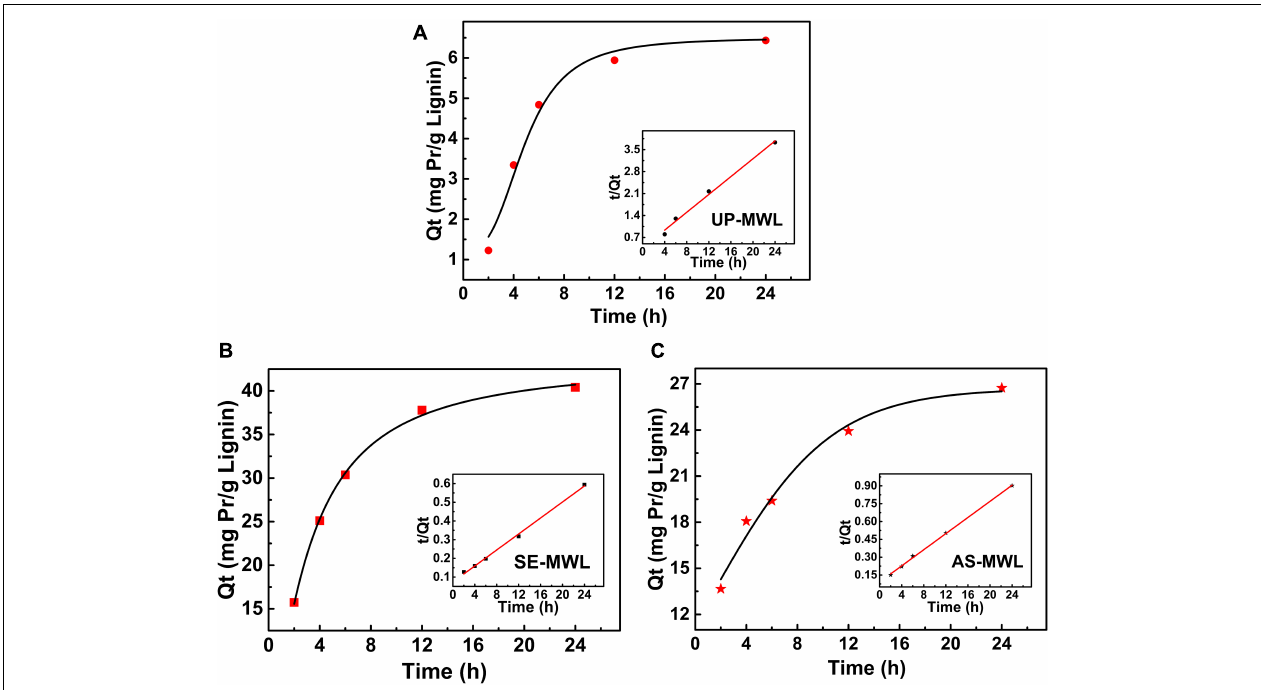
FIGURE 4 | The pseudo-second-order kinetic model of adsorption of Xyn10A onto lignins from unpretreated (A) and different pretreated corn stover by SE (B) or AS (C) . AS, ammonium sulfite; SE, steam explosion.